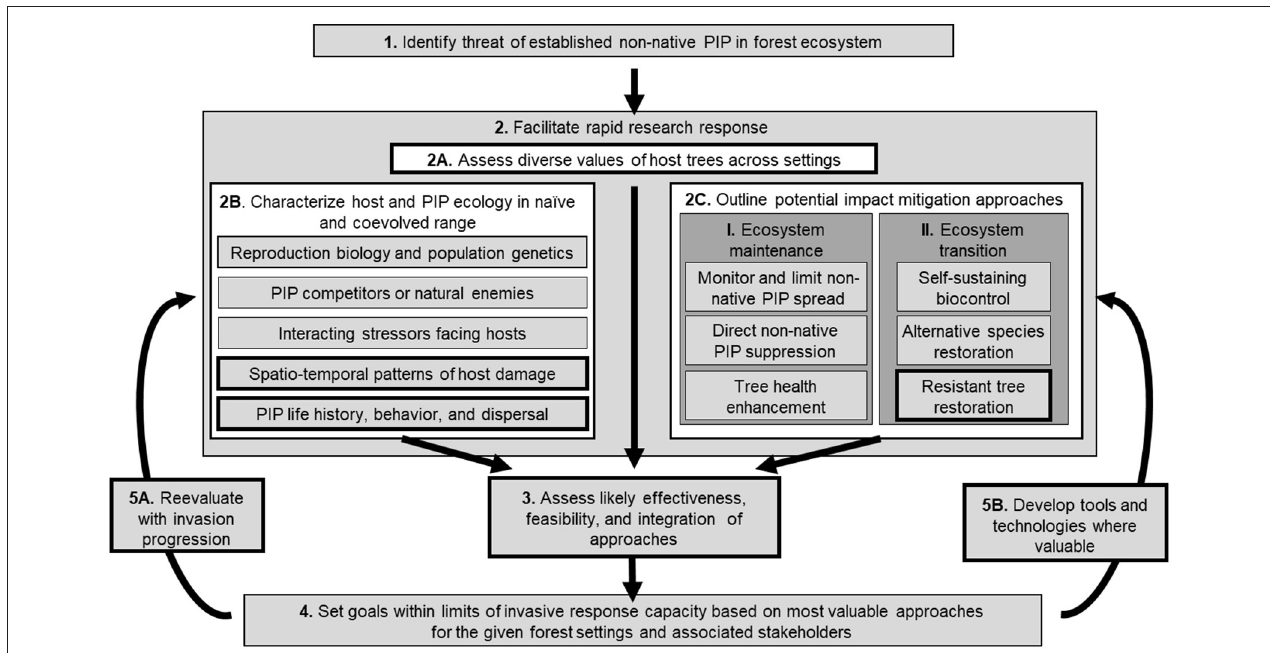
FIGURE 2 | Contextualizing host resistance development within the generalized response framework for established, non-native forest phytophagous insects and phytopathogens (non-native PIPs). (1) Once a non-native PIP is identified as established in a forest ecosystem, research responses (2) must assess cultural, economic, and ecological value of hosts in various settings (2A), characterize the invasion ecology in native and introduced ranges to assess impact risk (2B), and outline available short- and long-term impact mitigation approaches (2C). (3) Likely costs and benefits of various approaches are estimated with available data, and (4) goals are set within limits of current response capacity for the forest ecosystem under consideration. Response goals are periodically revised through the framework (5), with reevaluation of invasion progression (5A) and the development of new mitigation strategies or technologies (5B). Bolded boxes identify key steps in identifying good non-native PIP candidates for host resistance development: non-native PIPs threaten substantial long-term ecological and economic value; non-native PIPs are intimately associated with hosts and damage critical tissues resulting in rapid tree mortality; capacity for restoration using improved resistant germplasm exists or can be developed; mechanisms exist to reevaluate responses as invasion progresses and technologies